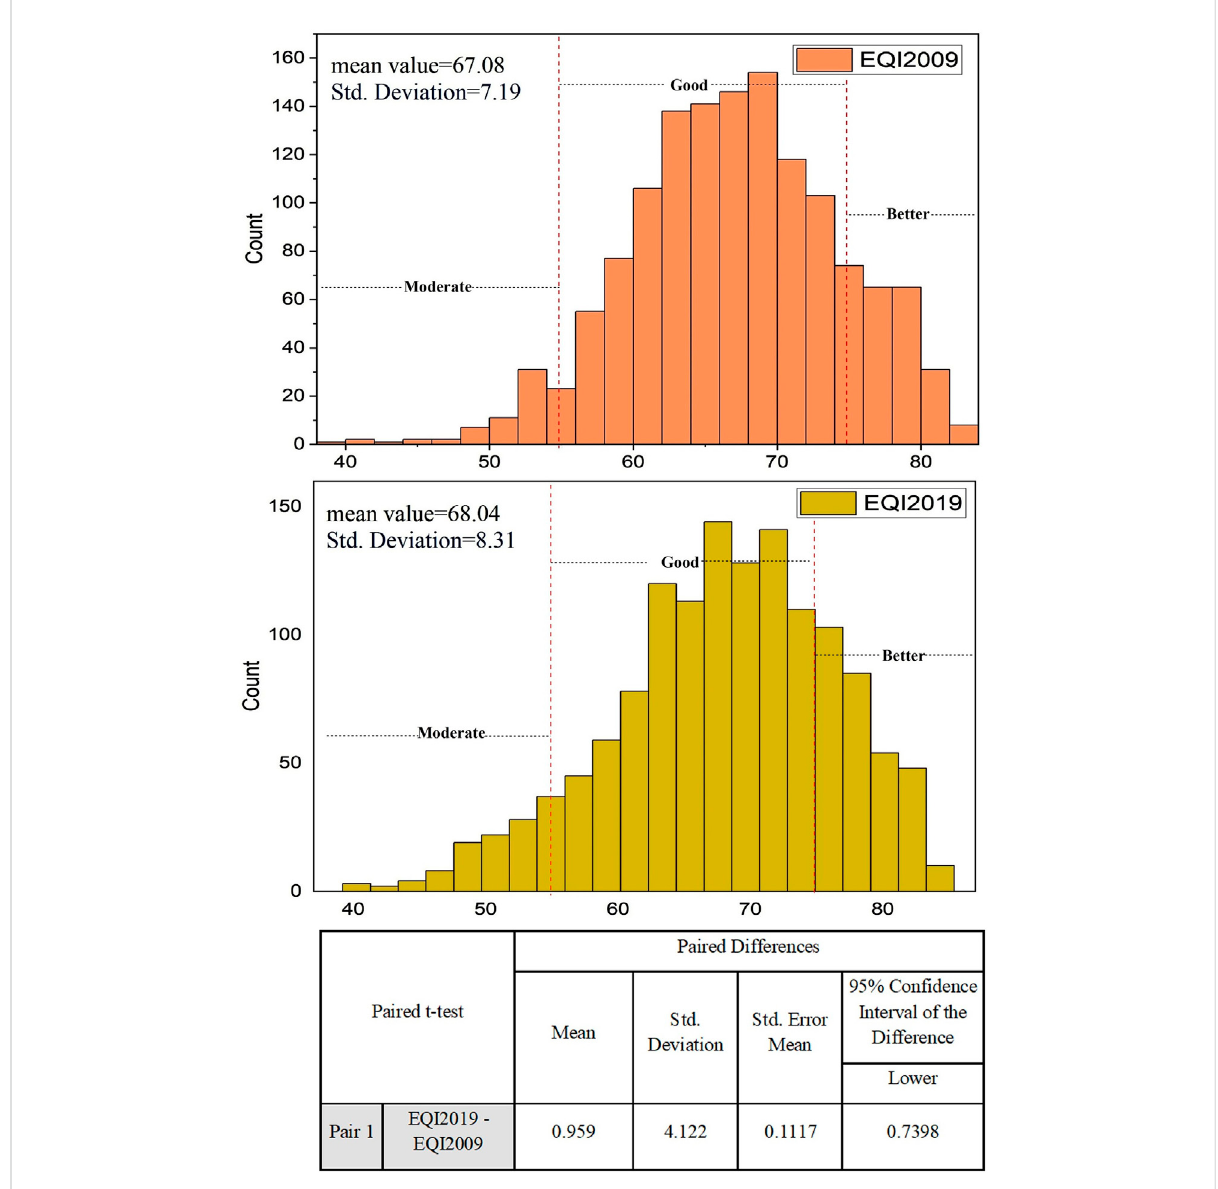
FIGURE 9 EQI value distribution in year 2009 and 2019 (Including paired t